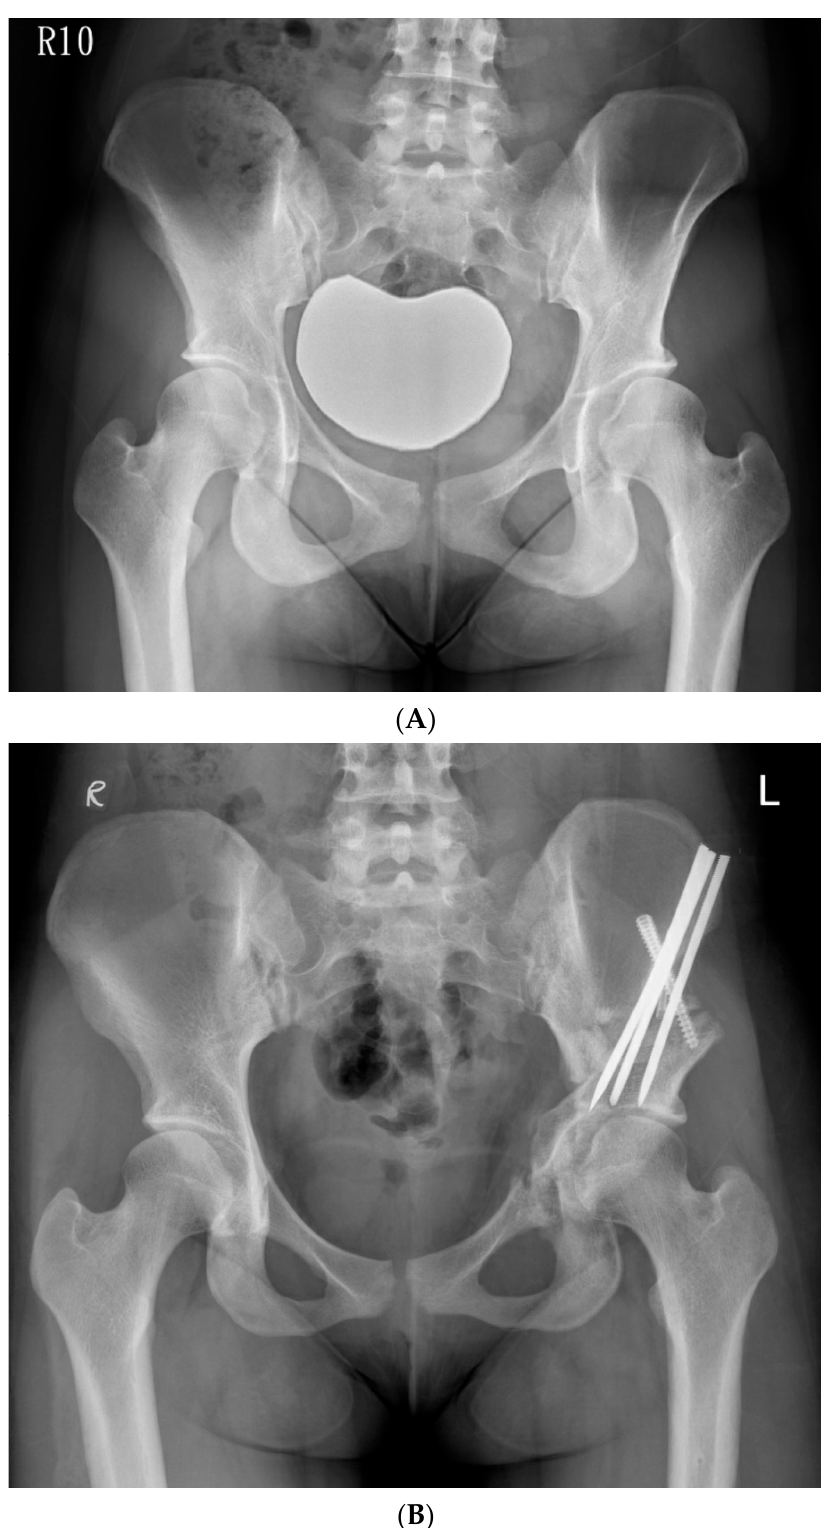
Figure 3. ( A ) Preoperative anteroposterior standing radiograph of a 19-year-old woman who un- derwent Ganz Osteotomy for symptomatic left hip dysplasia. ( B ) Postoperative anteroposterior standing radiograph showed good coverage of the femoral head.